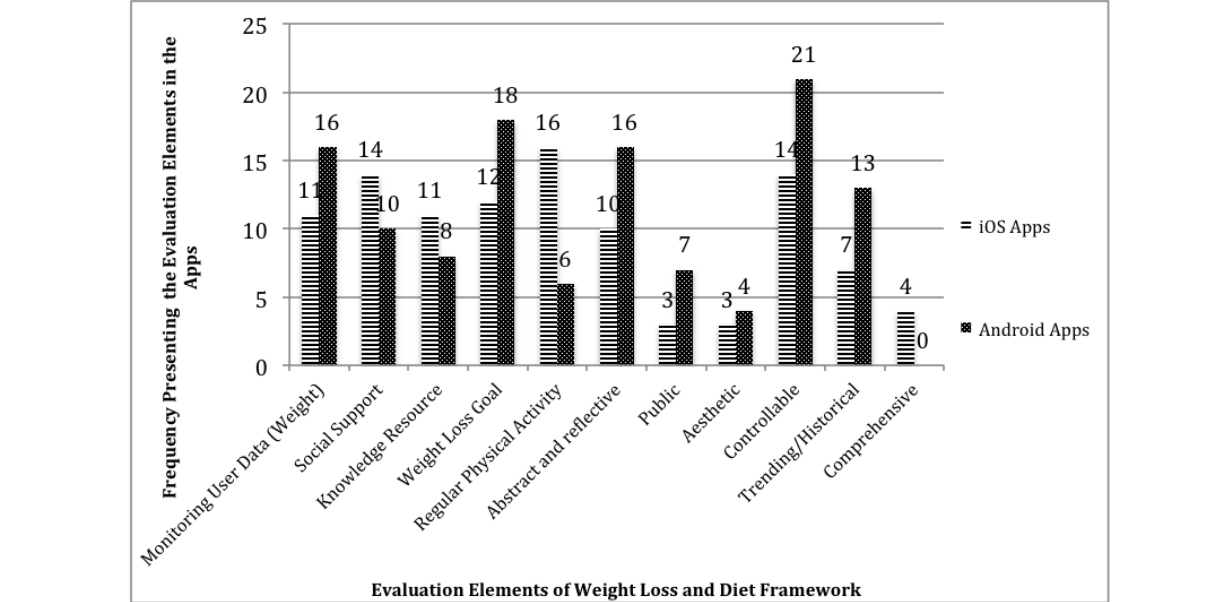
Figure 2. The presence of the evaluation elements in iOS and Android